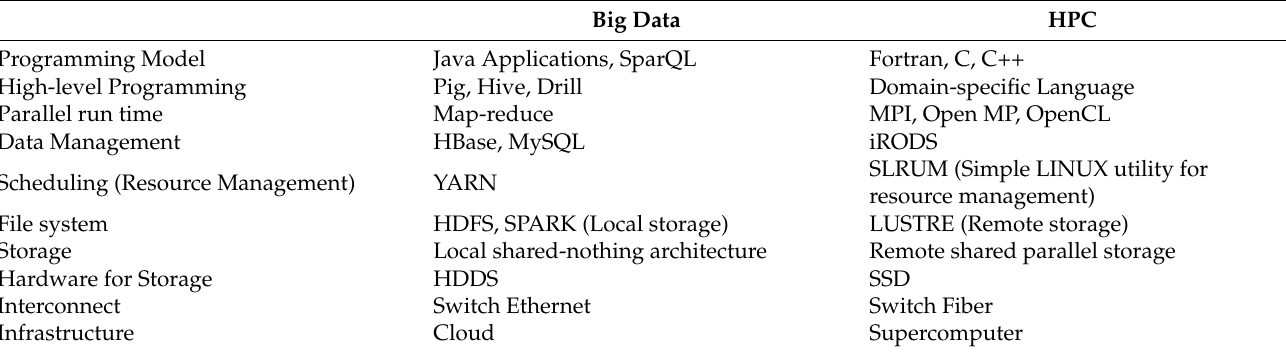
Table 3. HPC vs. Hadoop